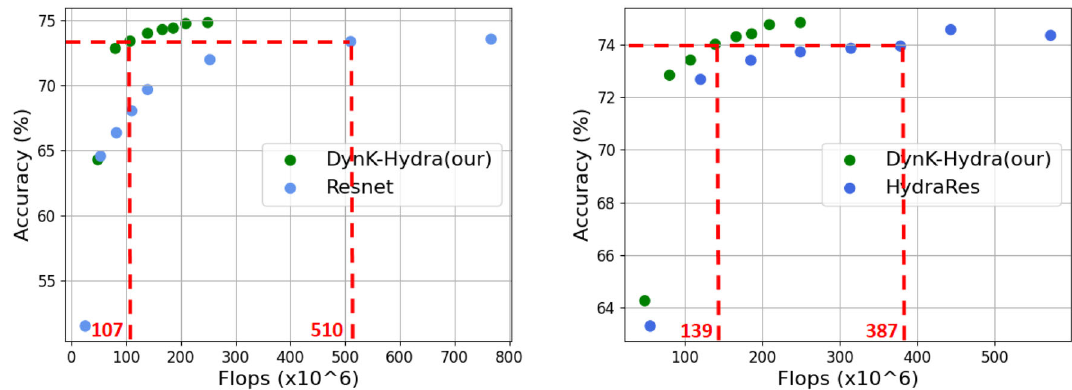
Fig. 4 Accuracy per computing units (flops) plot for CIFAR-100. Comparison of our DynK-Hydra to the State-of-the-Art Resnet [10] (left image) and HydraRes [5] (right